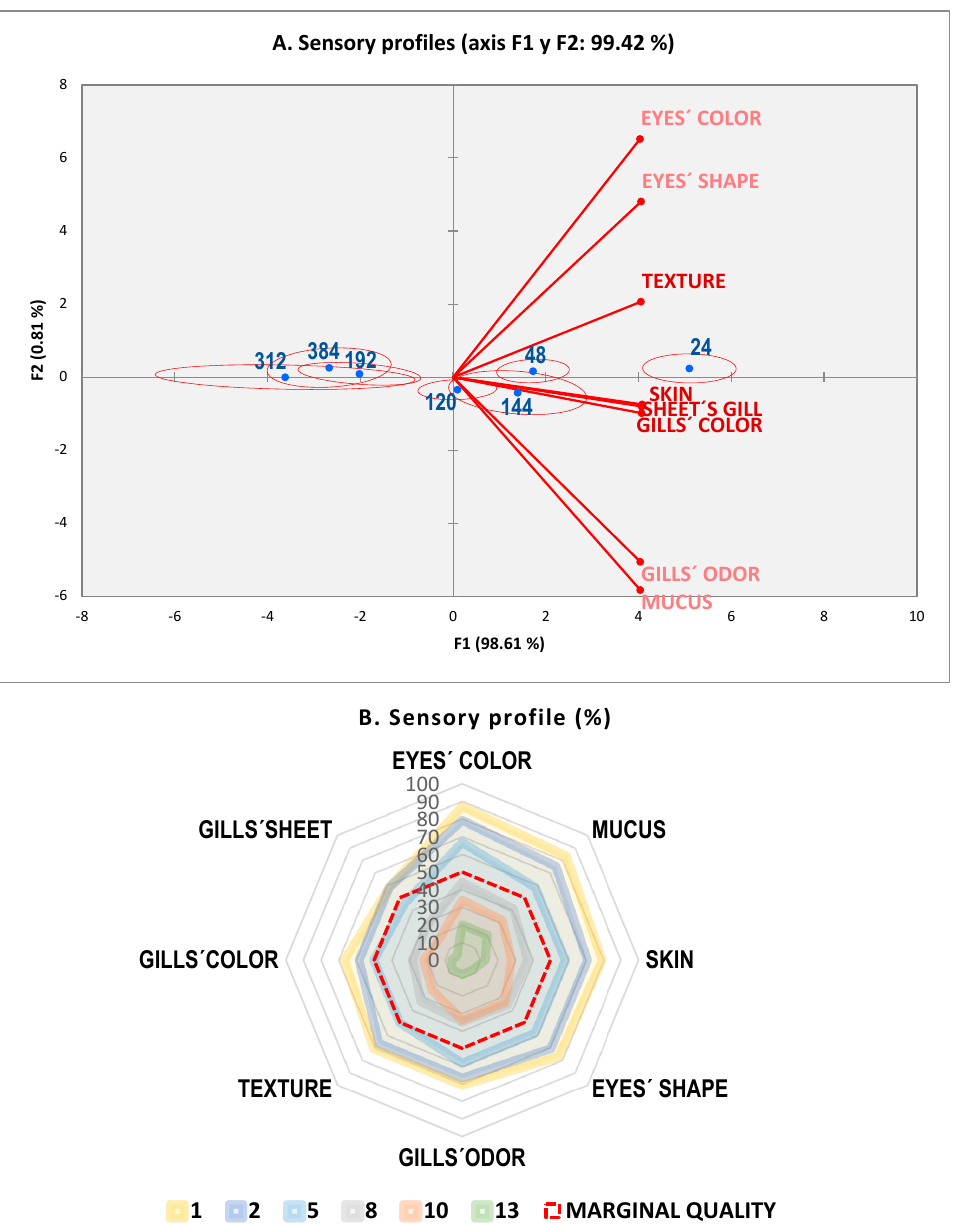
Figure 1. Spoilage over storage time (0 ± 1 °C) by the Quality Index Method (QIM), ( a ) sensory profiles by square cosines coefficients, and ( b ) radial profiles (%) by days.